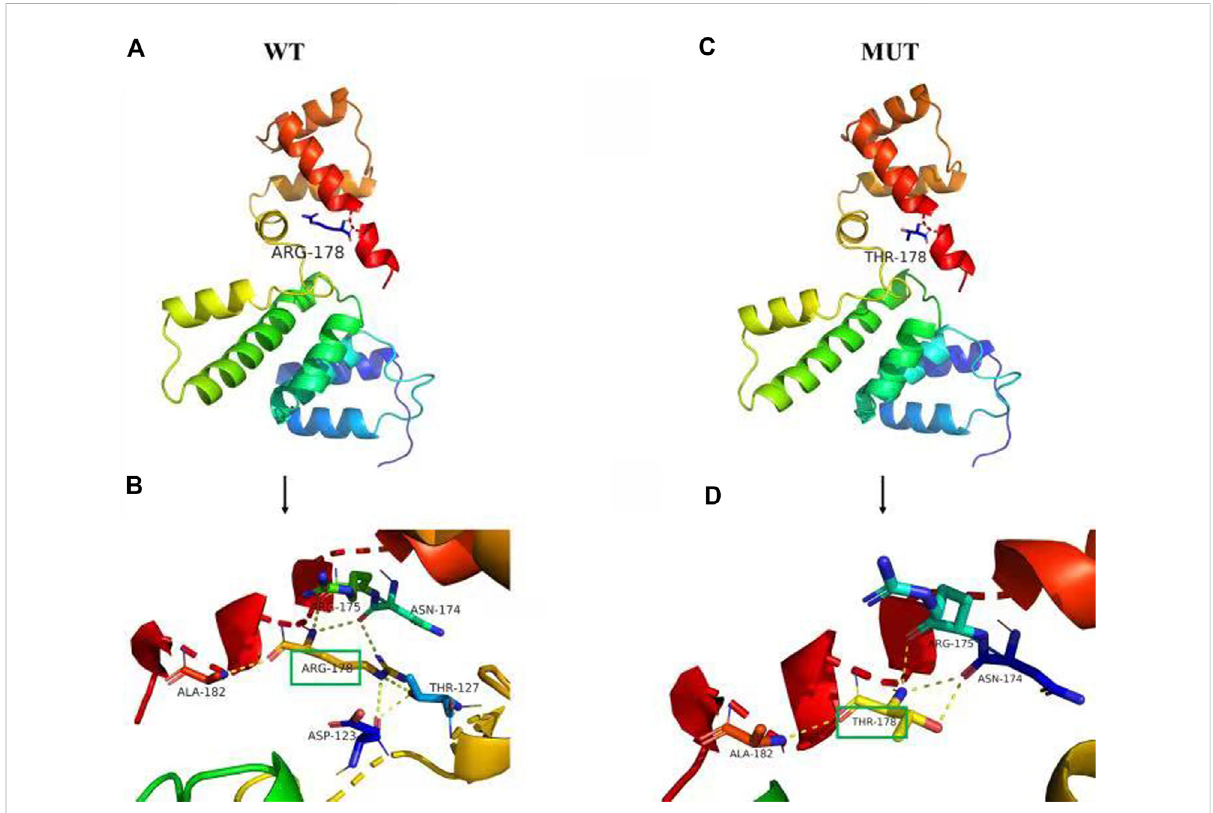
FIGURE 3 Prediction of the tertiary structure of SIX1 protein. The novel variant of the SIX1 gene is c.533 G > C, p.R178T (p.Arg178Thr), (A) is the 3D overall picture of wild-type (WT) SIX1 protein: the 178th amino acid is ARG. (B) is the 3D partial enlarged view of WT SIX1 protein. The 178ARG respectively form a hydrogen bond with the 123ASP, 127THR, 175 ARG, and 182 ALA, and 178ARG form two hydrogen bonds with 174ASN, together to maintain thestability oftheproteinstructure. (C) isthe3Doverallpictureofmutant(MUT)SIX1protein:the178thaminoacidismutated toTHR. (D) isthe 3D partial enlarged view of mutant SIX1 protein. No hydrogen bond interaction existed between the 178THR and 123ASP,